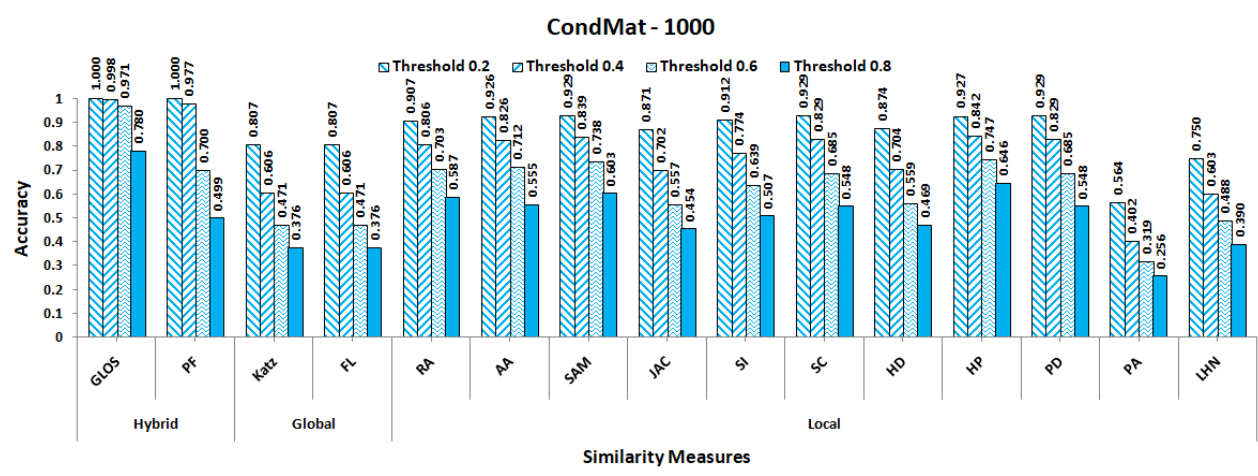
Figure 10. Comparisons of similarity measures on CondMat-1000 edge list from CondMat